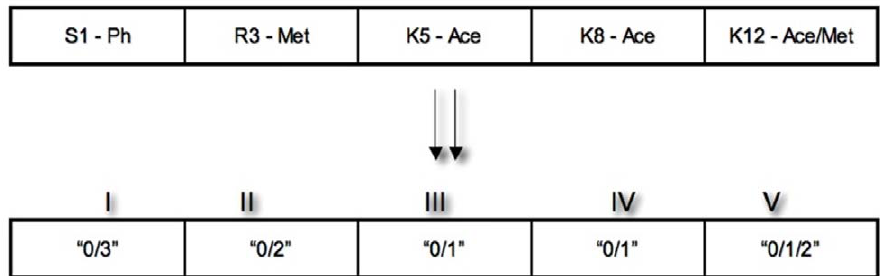
Figure 2. General representation of histone states in our model. The number of modifiable amino acids chosen for each histone type differs. In general, each modification is encoded as a number - Acetylation as ‘‘1’’, Methylation as ‘‘2’’, Phosphorylation as ‘‘3’’ and no modifications as ‘‘0’’. The string of numbers or the current Histone state represents the possible combination of modifications within that particular histone type.